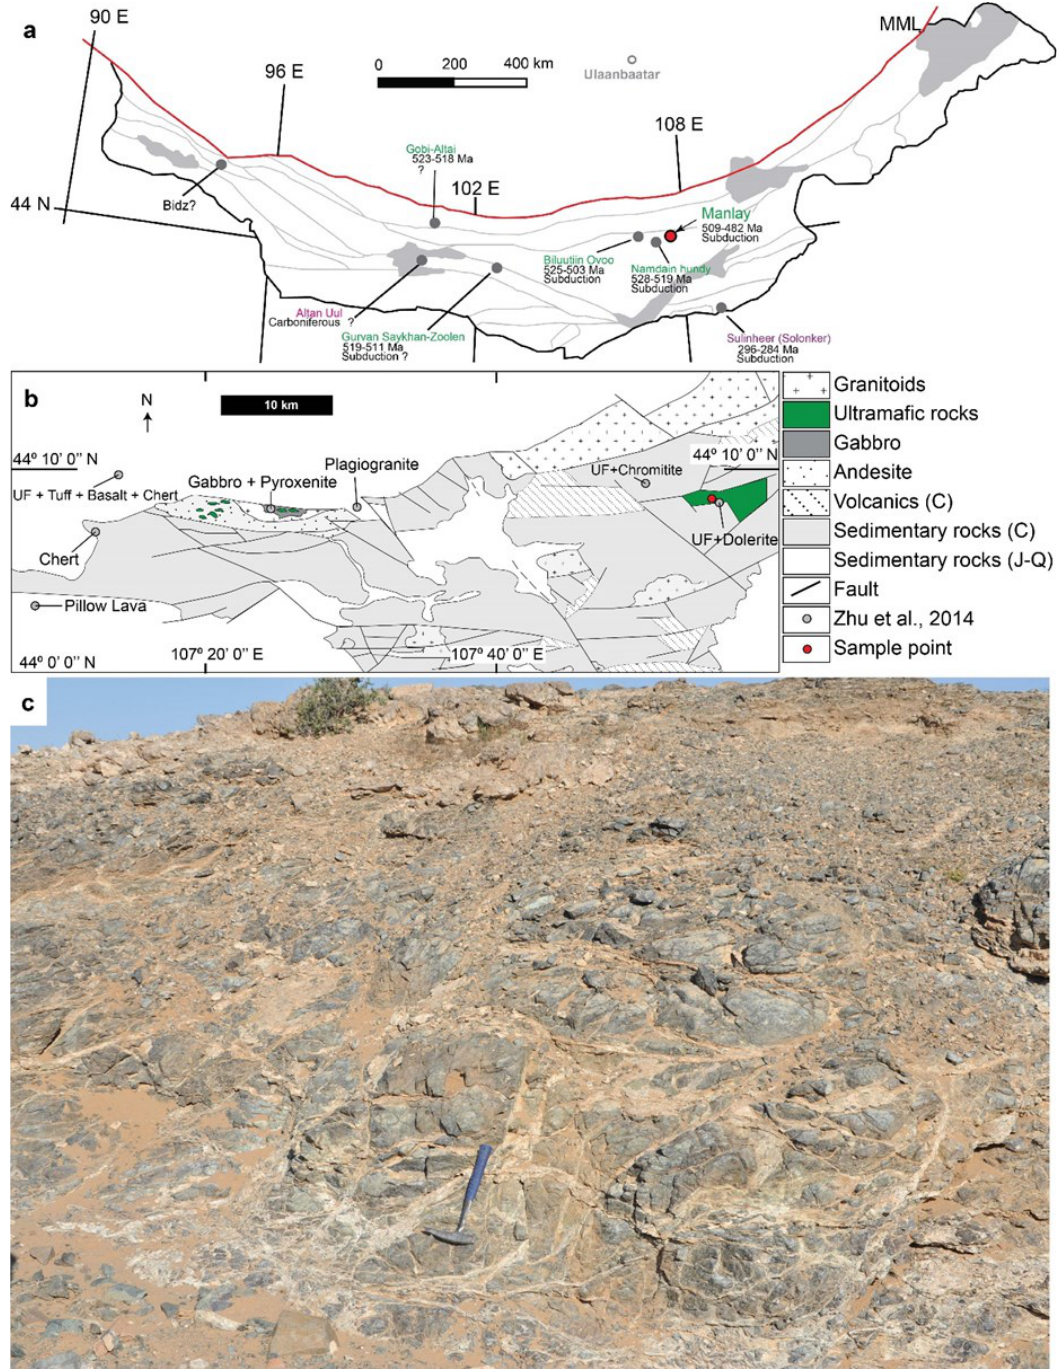
Fig. 1. Location of the Manlay Ophiolite. (a) Simplified terrane map of southern Mongolia and ophiolite distribution in southern Mongolia (modified from Badarch et al., 2002; Furnes and Safonova, 2019). Ophiolites are shown with ages and tectonic setting. Question marks indicate uncertain ages or tectonic setting. The gray open circle indicates the location of the city of Ulaanbatar. Gray circles indicate localities of ophiolite in southern Mongolia. The red circle shows the location of the Manlay Ophiolite. The red line is the Main Mongolian Lineament (MML). C, J and Q indicate Carboniferous, Jurassic and Quaternary, respectively (b) Simplified geological map of the eastern side of the Manlay Ophiolite (modified from Zhu et al., 2014a). (c) Field photo of serpentinite in the Manlay Ophiolite. Carbonate veins cut across the serpentinite